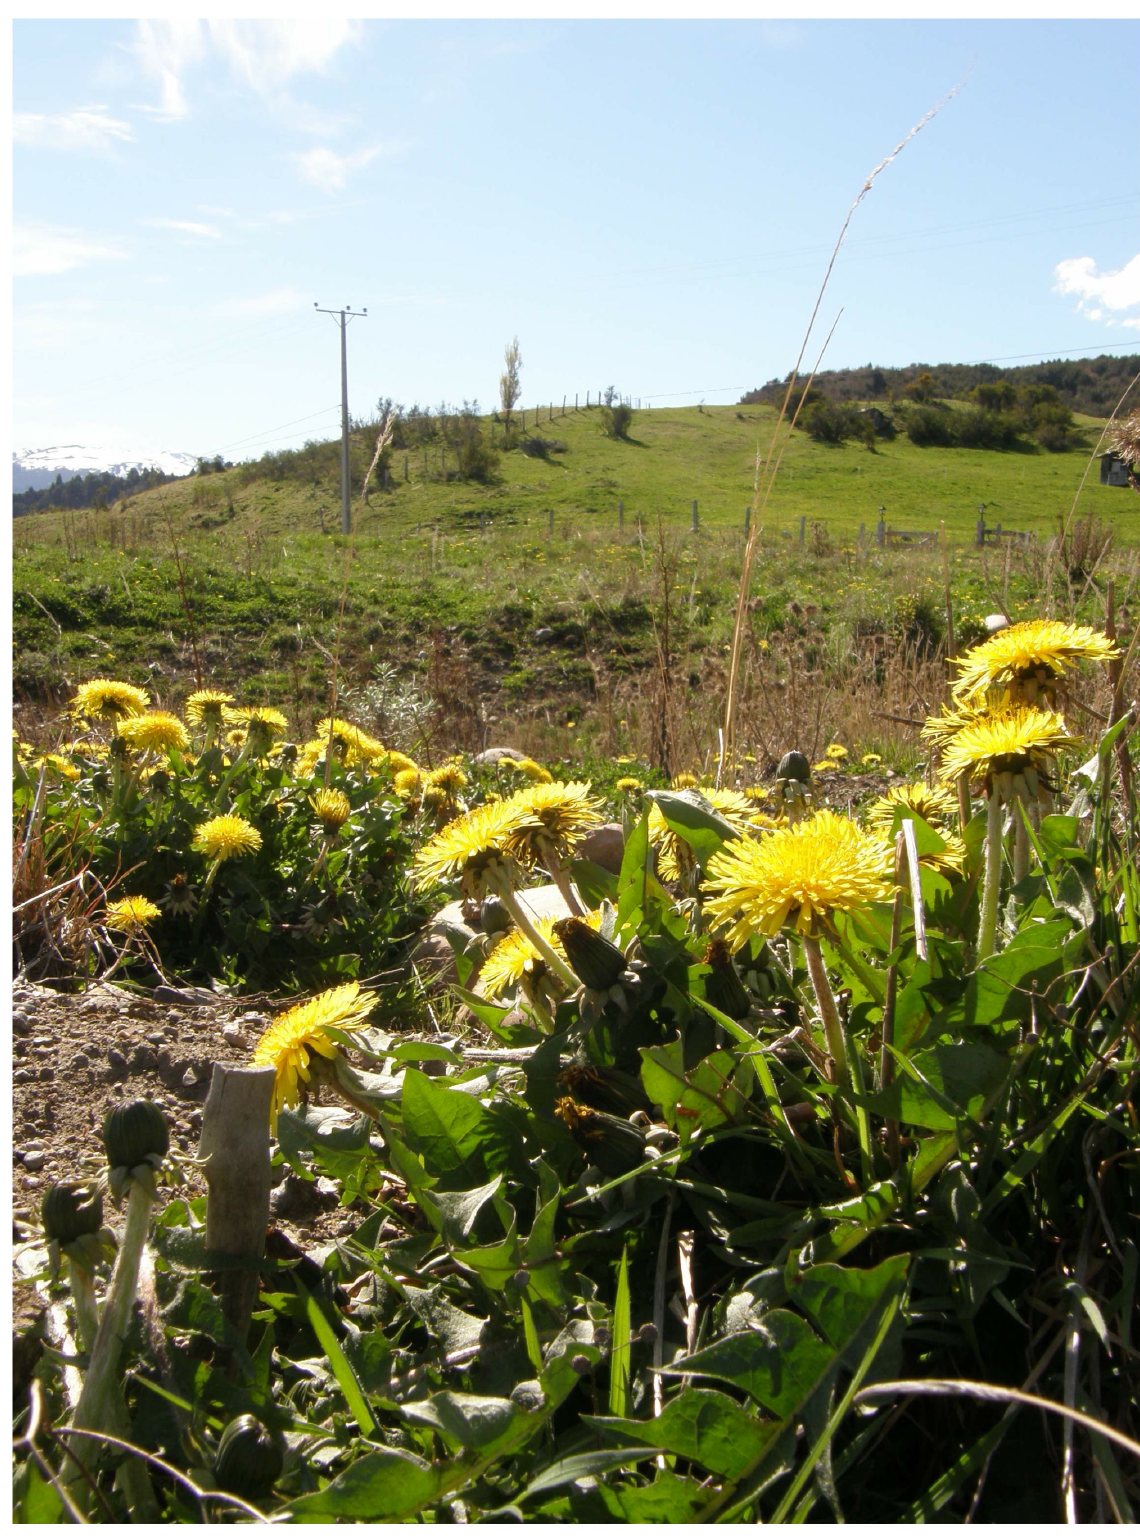
Figure 1. Taraxacum officinale population growing in the field in southern Chile. Photographed by Alejandra Lafon and Marco A. Molina-Montenegro in March 2009. doi: 10.1371/journal.pone.0076432.g001 PLOS ONE | www.plosone.org